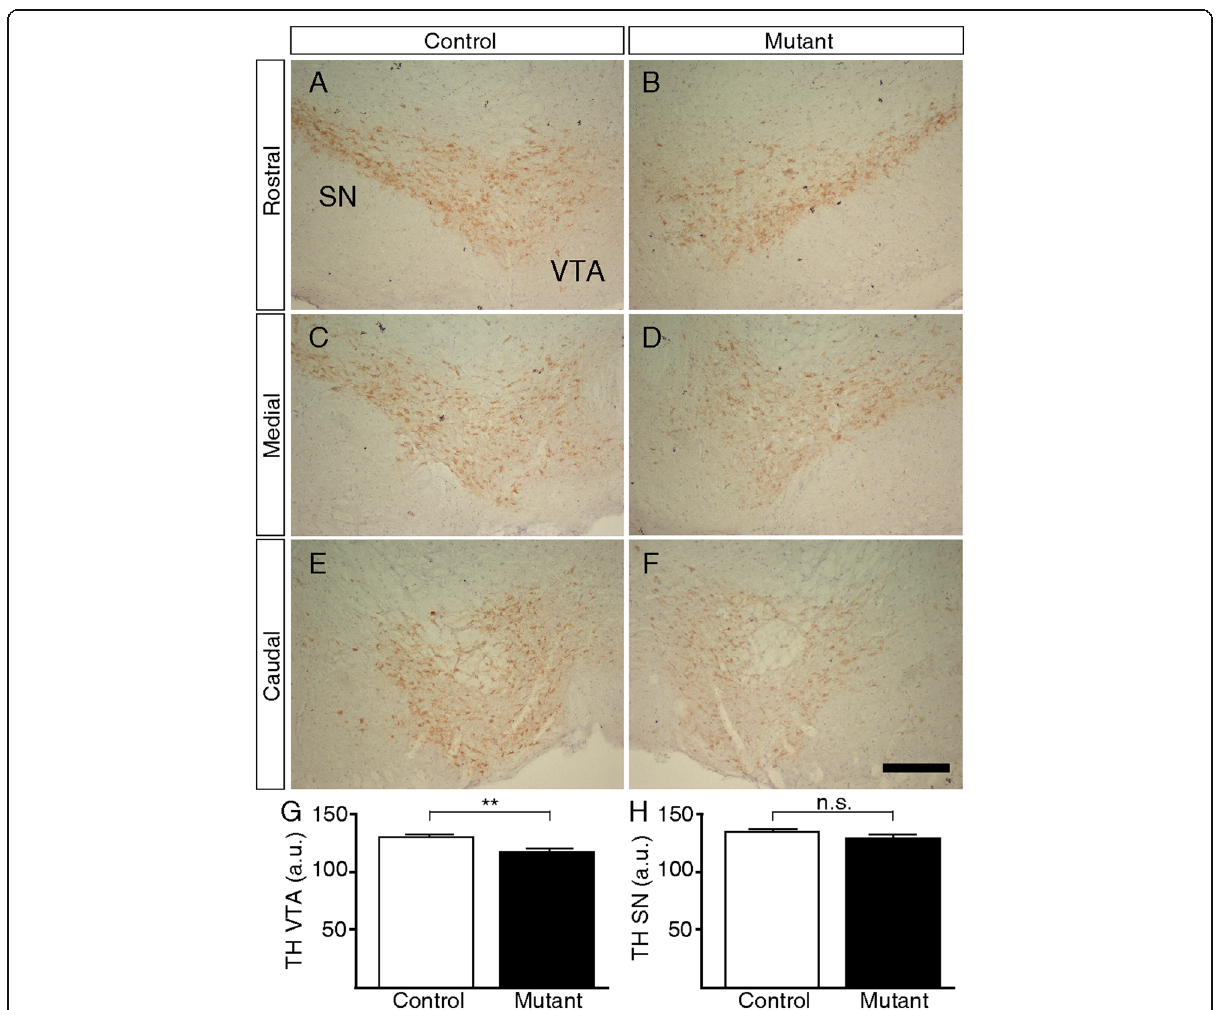
Fig. 3 TH expression level assessment by immunohistochemistry. Brain sections spanning rostral ( a , b ), medial ( c , d ), or caudal ( e , f ) sections of the SN/VTA from control ( a , c , e ) or mutant ( b , d , f ) animals. Digital quantification of TH expression in the VTA ( g ) and SN ( h ). t test, ** p < 0,01. n.s. non-significant. All images are × 10 magnifications. SN substantia nigra, VTA ventral tegmental area. Scale bar 200 μ